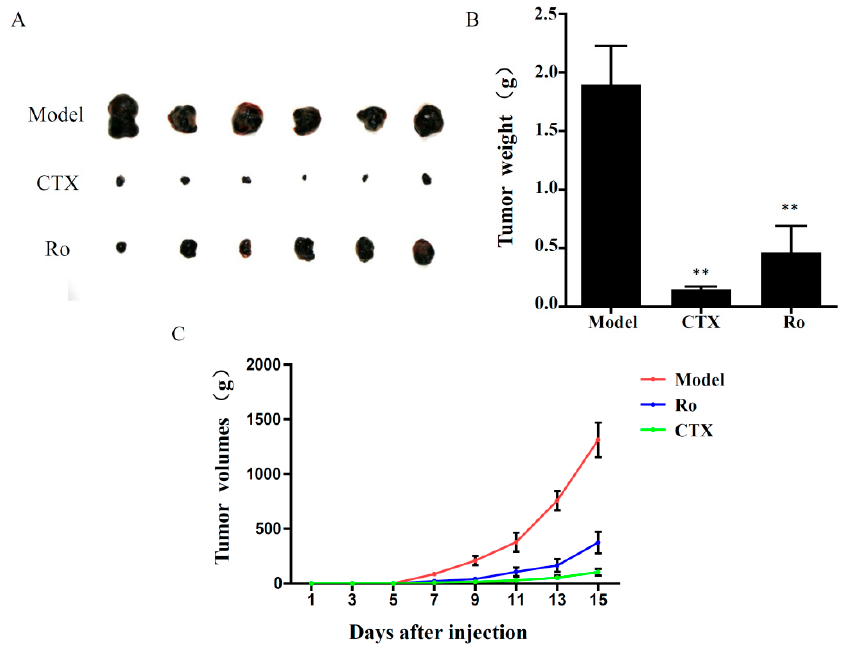
Figure 1. E ff ects of Ro on tumour growth in B16F10 tumour-bearing mice. ( A ) Image of tumour masses. ( B ) Weight of tumour masses. ( C ) Tumour volume changes in B16F10 tumour xenograft mice. ** p < 0.01 vs. model group. CTX: cyclophosphamide. Table 1. E ff ects of Ro on body weight and organ indices in B16F10 tumour-bearing mice. Weight Groups Dosage (mg / kg)